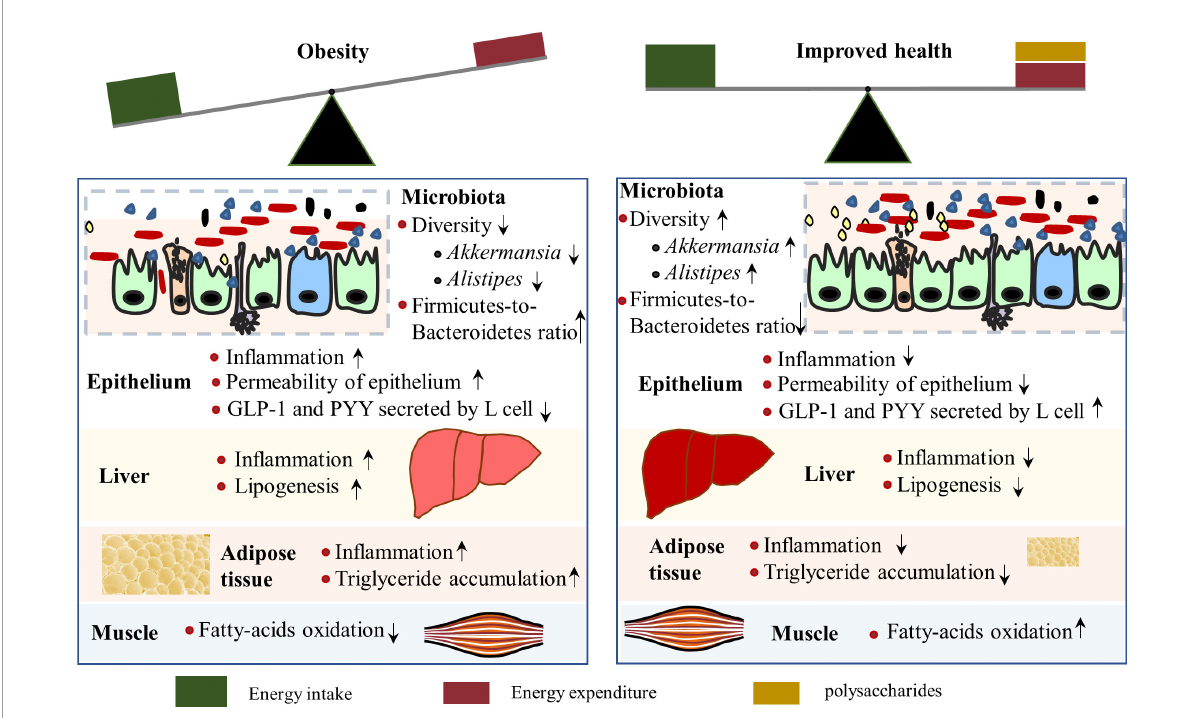
FIGURE4 Mechanisms by which polysaccharides alleviate obesity. A polysaccharide-rich diet contributes to the maintenance of a healthy gut and reduces inflammation of the liver and adipose tissue (Right) . Intestinal microbiota composition is associated with obesity, of which low diversity, reduced abundance of Akkermansia and Alistipes , and enhanced Firmicutes-to-Bacteroidetes ratio were observed in obese individuals. However, polysaccharide supplementation can reverse the microbiota changes in obese situations, along with increased glucagon-like peptide 1 (GLP-1) levels, which is positively related to energy